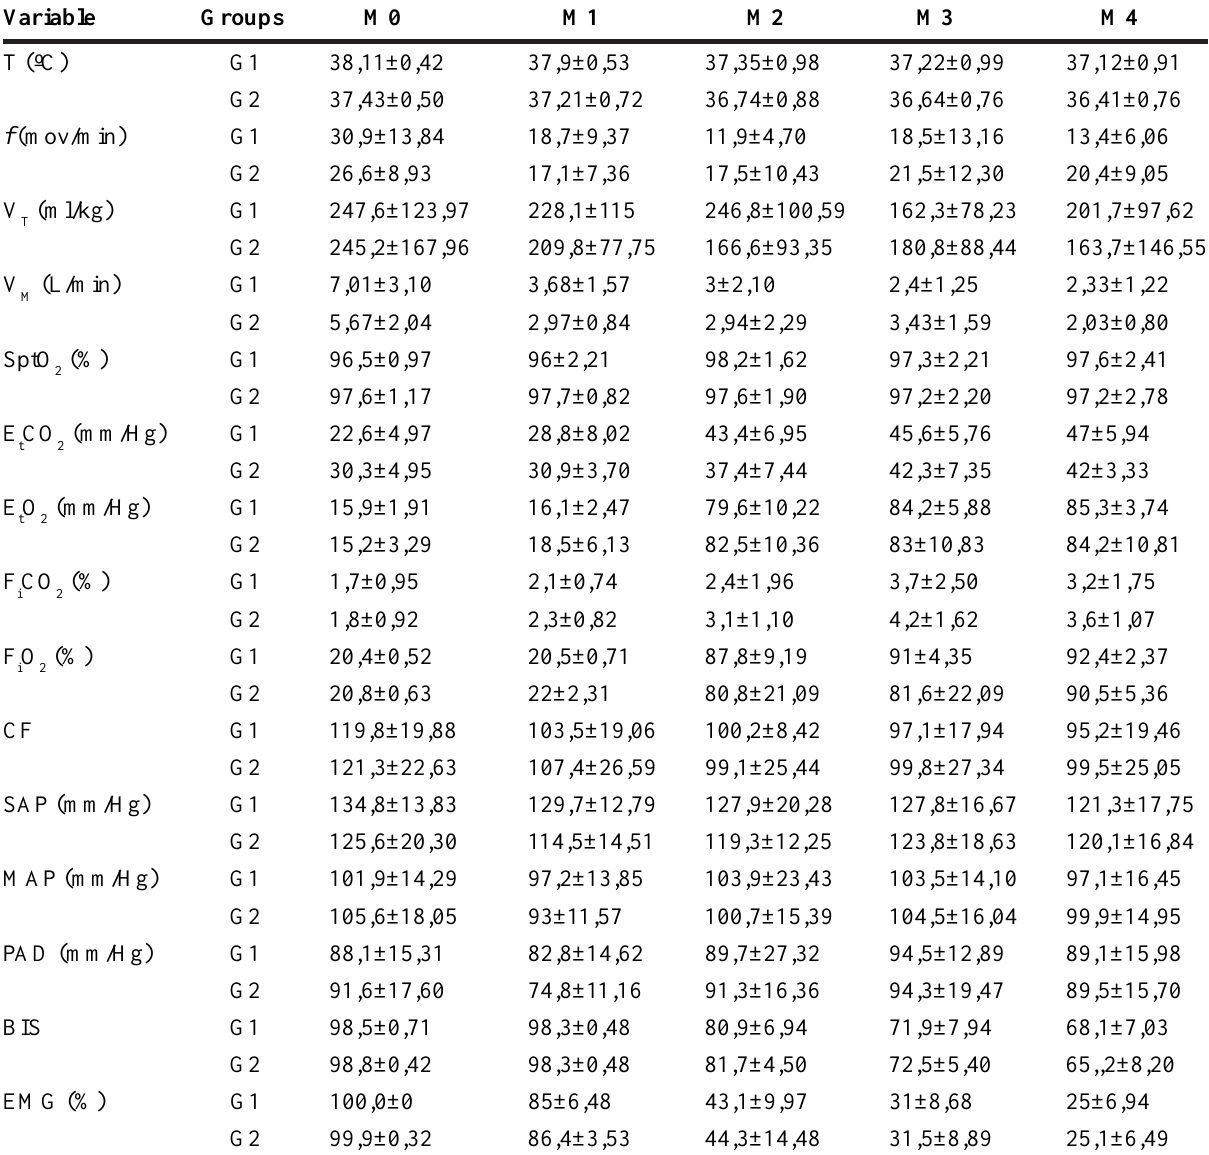
TABLE 1 - Anesthetic evaluation (means and standard -deviations) in adults females dogs treated with